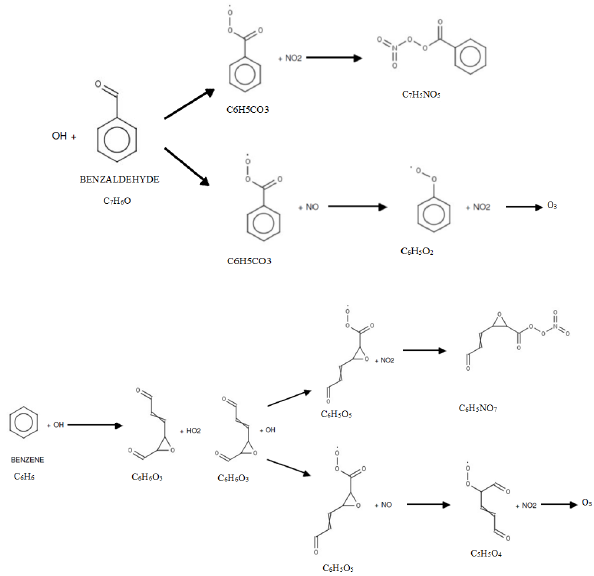
Figure 7. Examples of oxidation schemes that are common to all the VOCs that have as products PNs and O 3 . Upper panel: structural formula of the oxidation of benzaldehyde that directly produces per- benzoyl nitrate (C 7 H 5 NO 5 ) and O 3 . Lower panel: structural for- mula of the oxidation of benzene that produces O 3 and indirectly the PN (C 6 H 5 NO 7 )